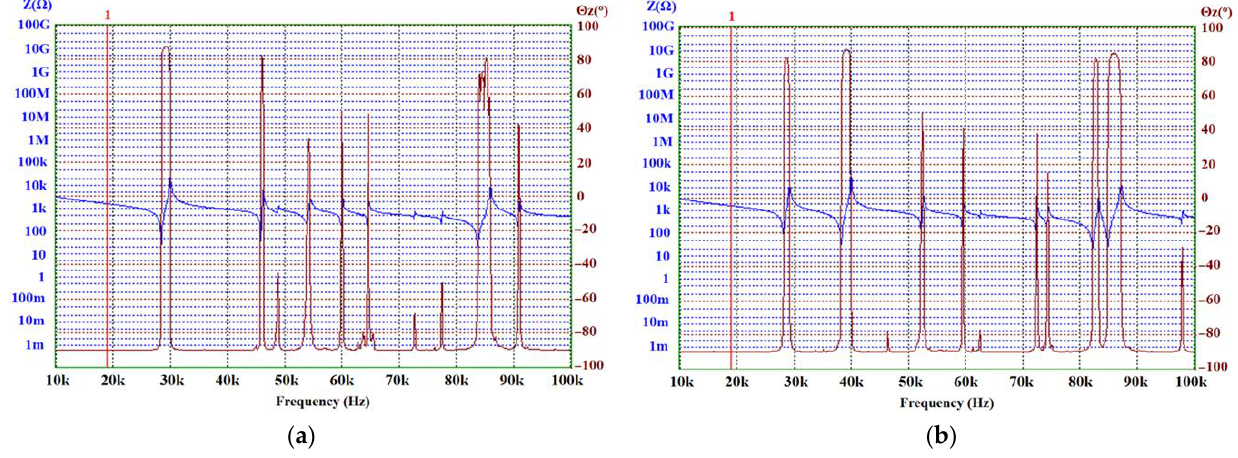
Figure 10. Experimental impedance–phase vs. frequency characteristics: ( a ) the electric impedance of the transducer with flat surface; ( b ) the electric impedance of the transducer with ring-shaped